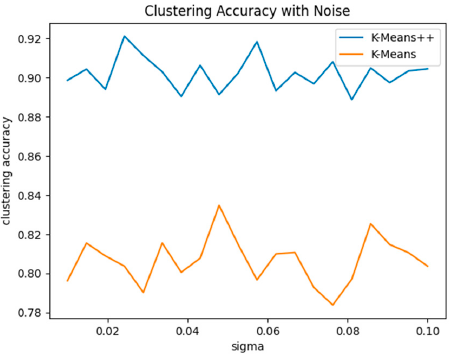
Figure 13. K-Means++ and K-Means clustering model sensitivity with noise standard